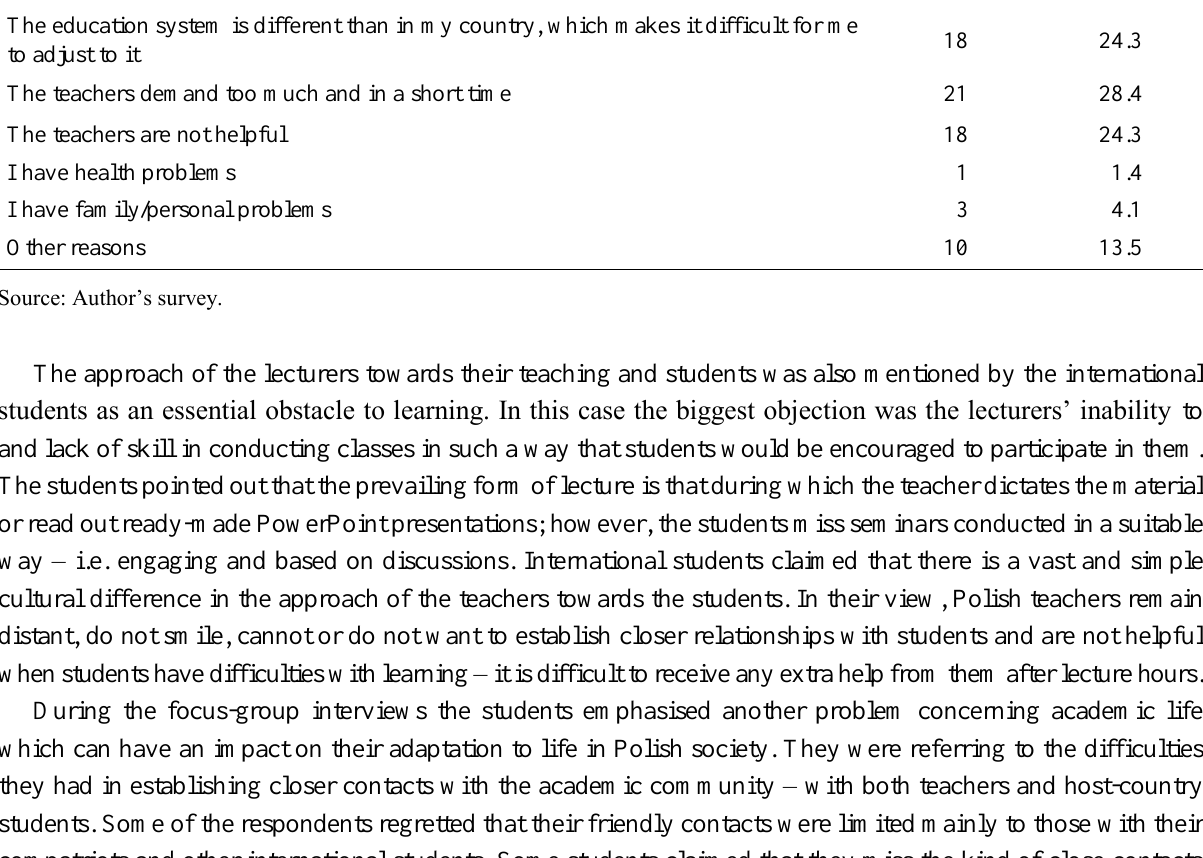
Table 4. International students’ perception of hardships having impact on their studies (N=74) Students could choose more than one answer N % There are too many subjects and too much information which I must learn and assim- ilate in a short time